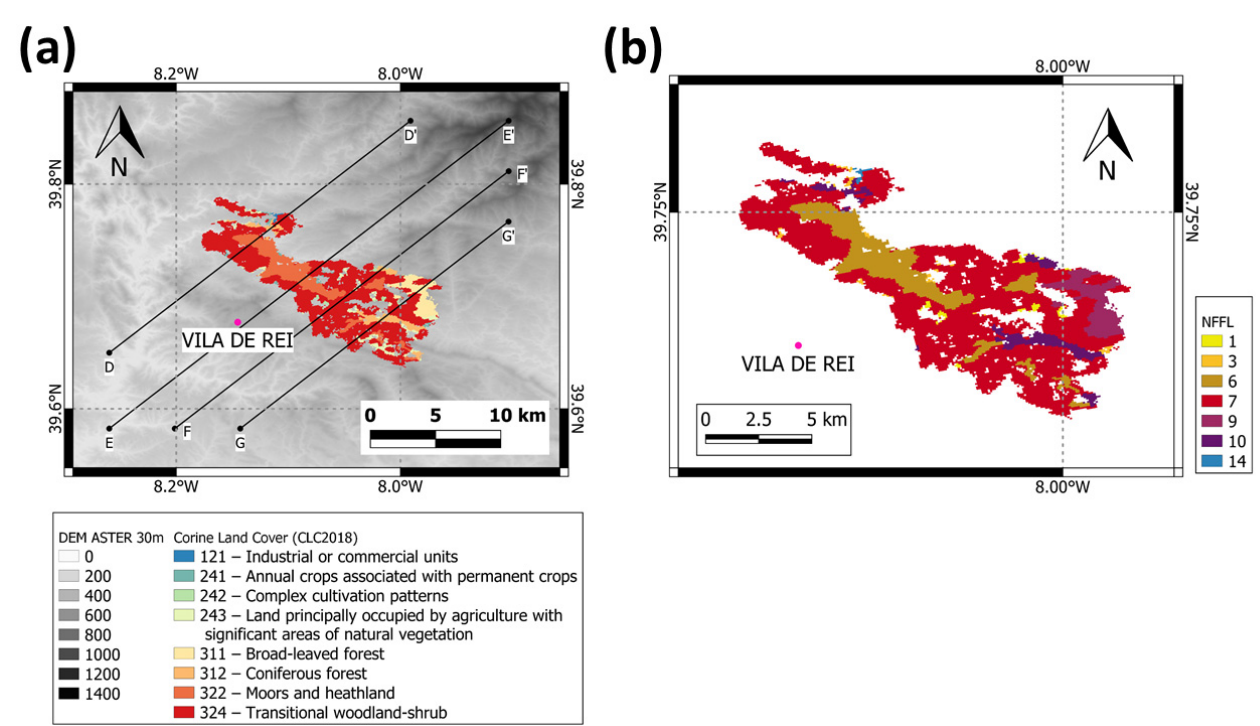
Figure 2. ( a ) Corine Land Cover from the 5th CLC inventory (CLC2018) for the total burnt area. The SW–NE vertical cross-sections are marked as D–D’, E–E’, F–F’ and G–G’. These cross-sections are used for the wind speed analysis given in Section 3.4; ( b ) Fuel models presented in the burned area according to the Northern Forest Fire Laboratory (NFFL) classification presented in [49].